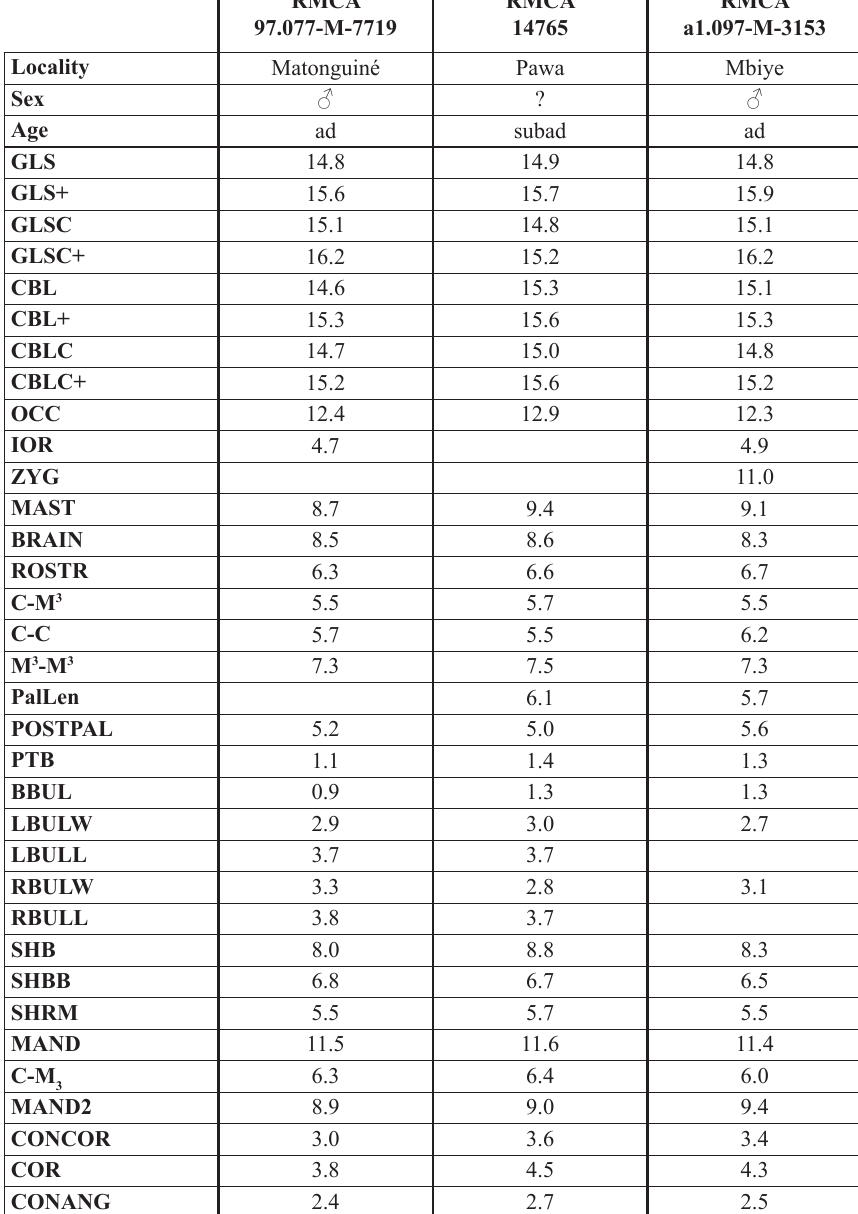
Table 2. Craniodental measurements (rounded to nearest 0.1 mm). For measurement descriptions see